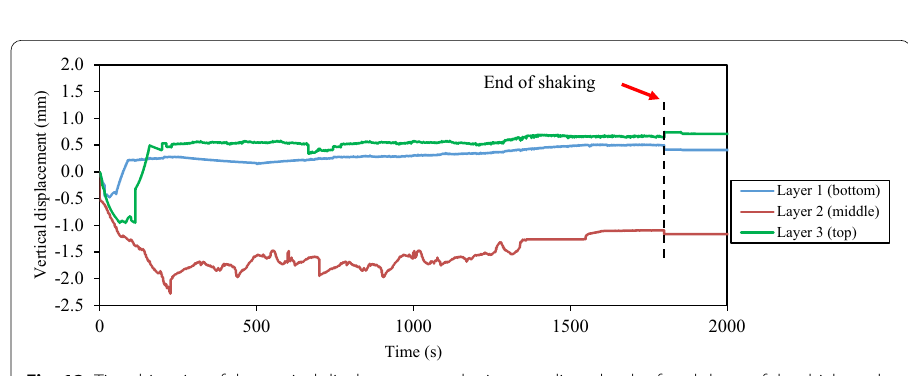
Fig. 12 Time histories of the vertical displacement at the intermediate depth of each layer of the thickened tailings deposit during shaking